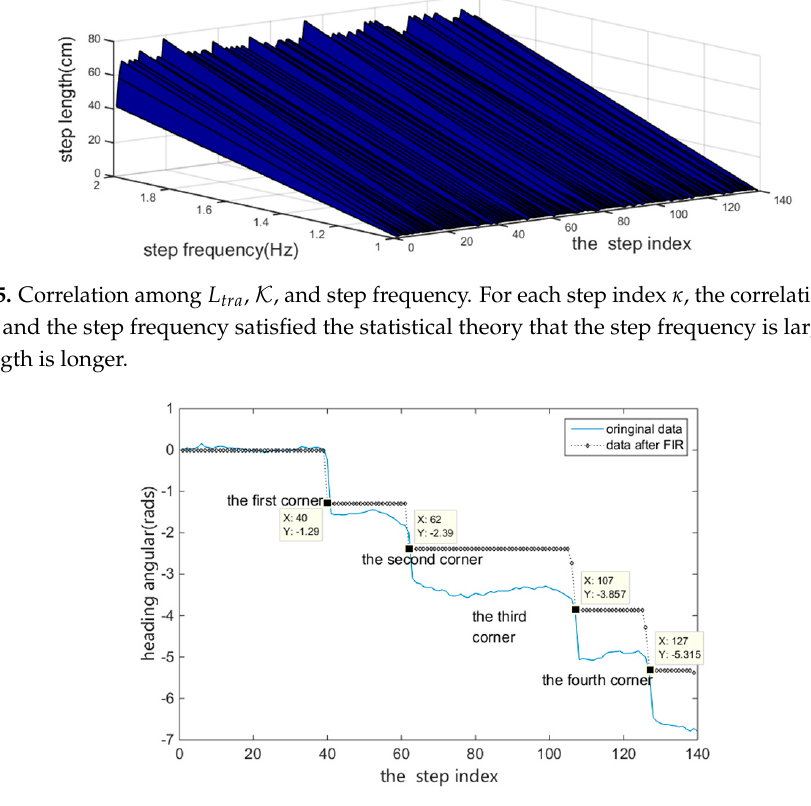
Figure 6. Heading angular θ and the corner step index. The heading angular θ at each κ is shown in a blue full line to clarify the κ of every room corner. FIR technology is applied. The index values of the corridor corners κ are shown in the black numbers.